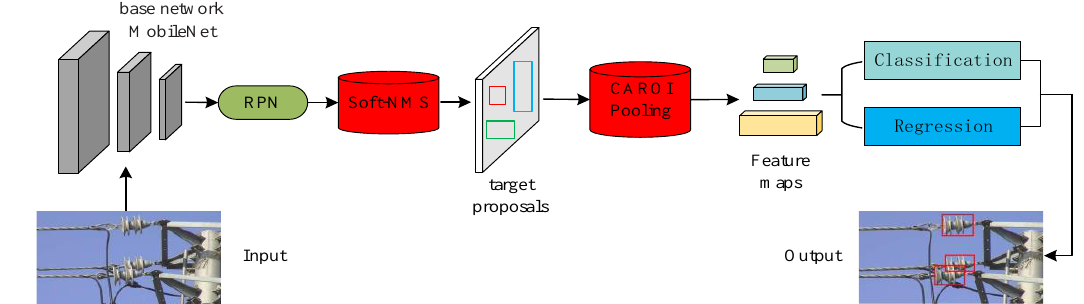
Figure 2. The overall framework of the improved Faster R-CNN.